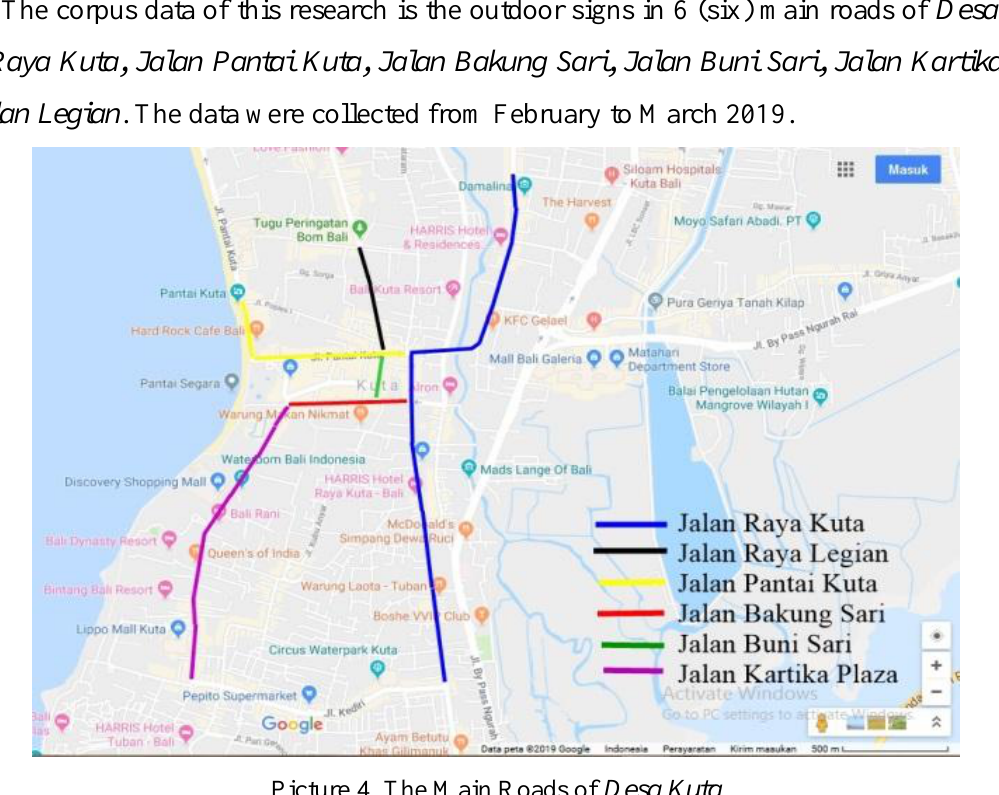
Picture 4. The Main Roads of Desa Kuta Source: Google